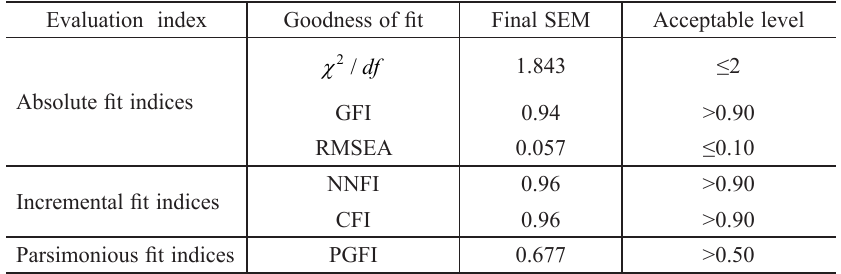
Table 3. Goodness of fit indices of the SEM framework